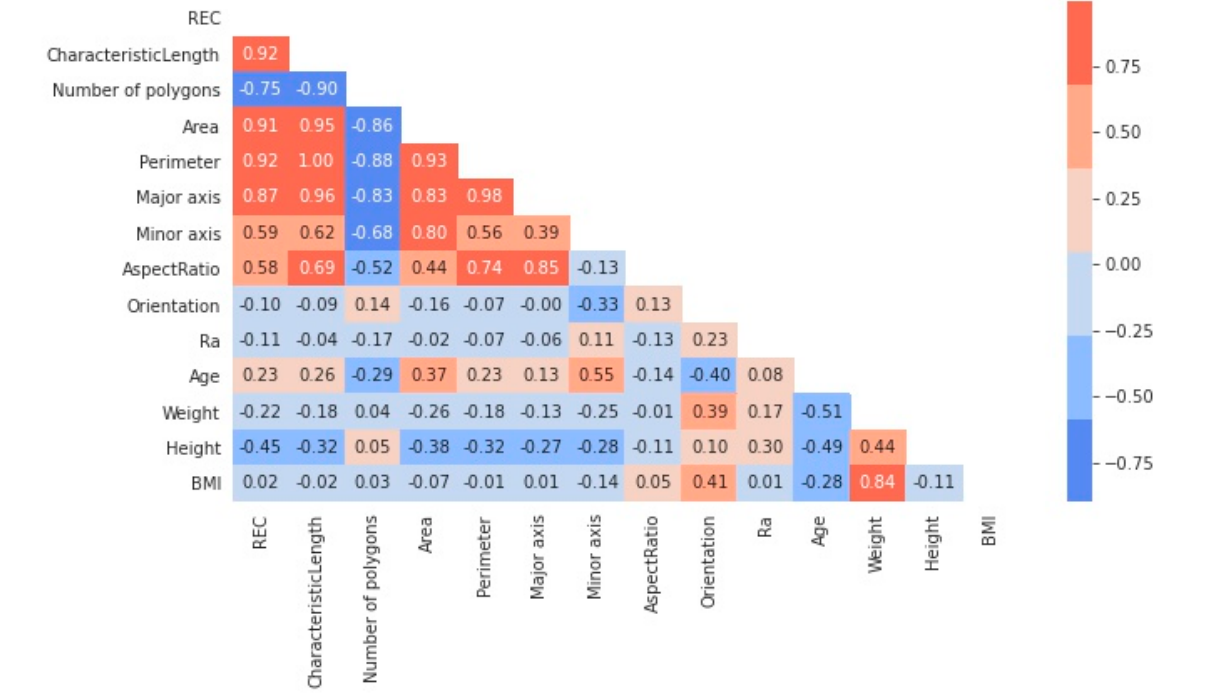
Figure 3. Heatmap of correlation coefficients (r) between all data (skin Elastin-to-Collagen Ratio, skin replica segmentation, roughness, and demographic). The stronger red and blue colours would then indicate strong positive and negative correlations, respectively.